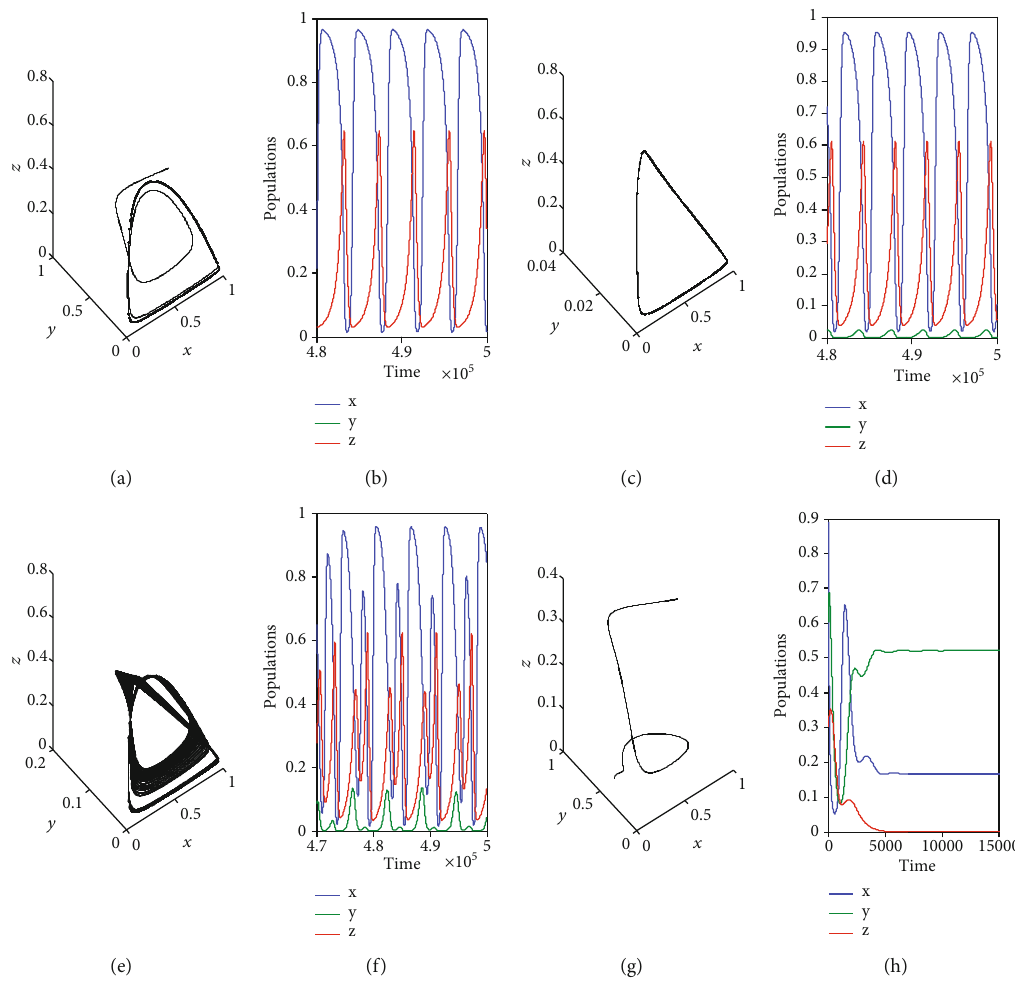
= 0 : 3 . (b) Time series 1